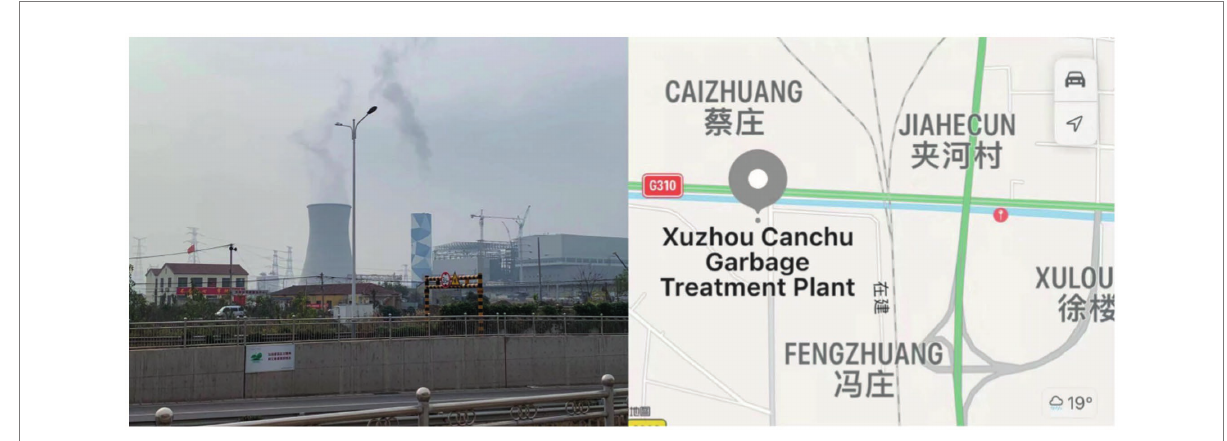
FIGURE 2 Xuzhou No. 2 waste incineration plant and its location (Photo taken by YH and